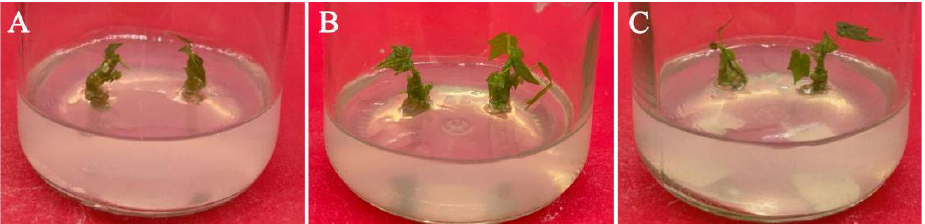
Figure 4. Elongation of adventitious buds on medium with different IAA concentrations: ( A ) 1/2 MS medium supplemented with 0.1 mg/L 6-BA and 1.0 mg/L IAA; ( B ) 1/2 MS medium supplemented with 0.1 mg/L 6-BA and 1.5 mg/L IAA; and ( C ) 1/2 MS medium supplemented with 0.1 mg/L 6-BA and 2.0 mg/L IAA. Table 10. Effect of 6-BA and IAA on the mean length of adventitious shoots (cm).